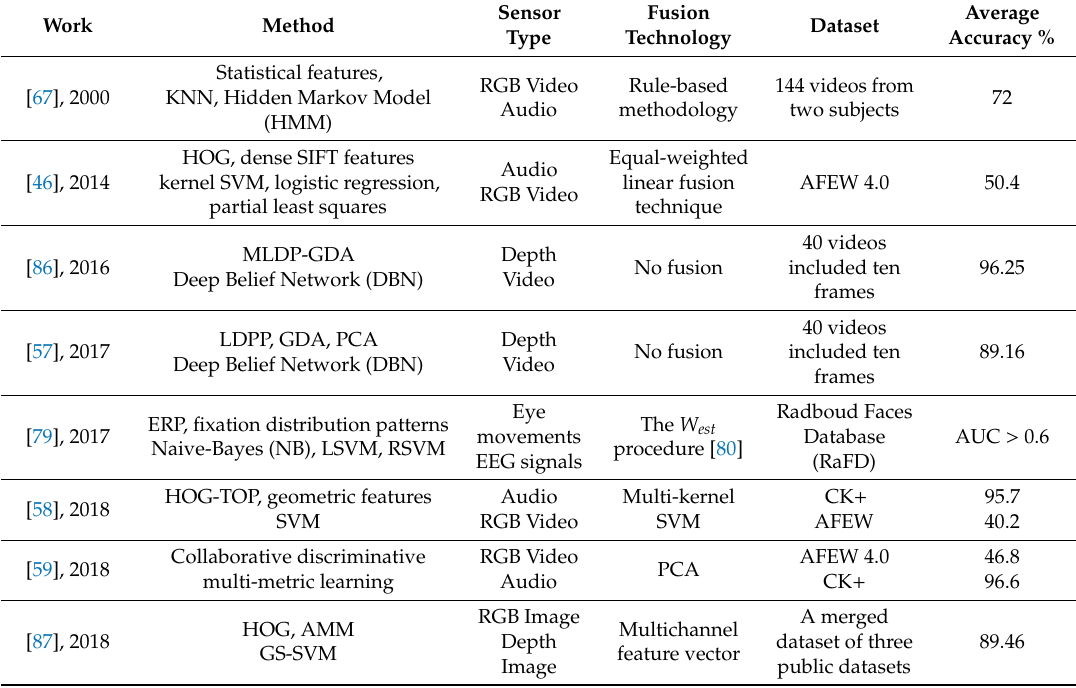
Table 4. Existing FER systems using non-visual